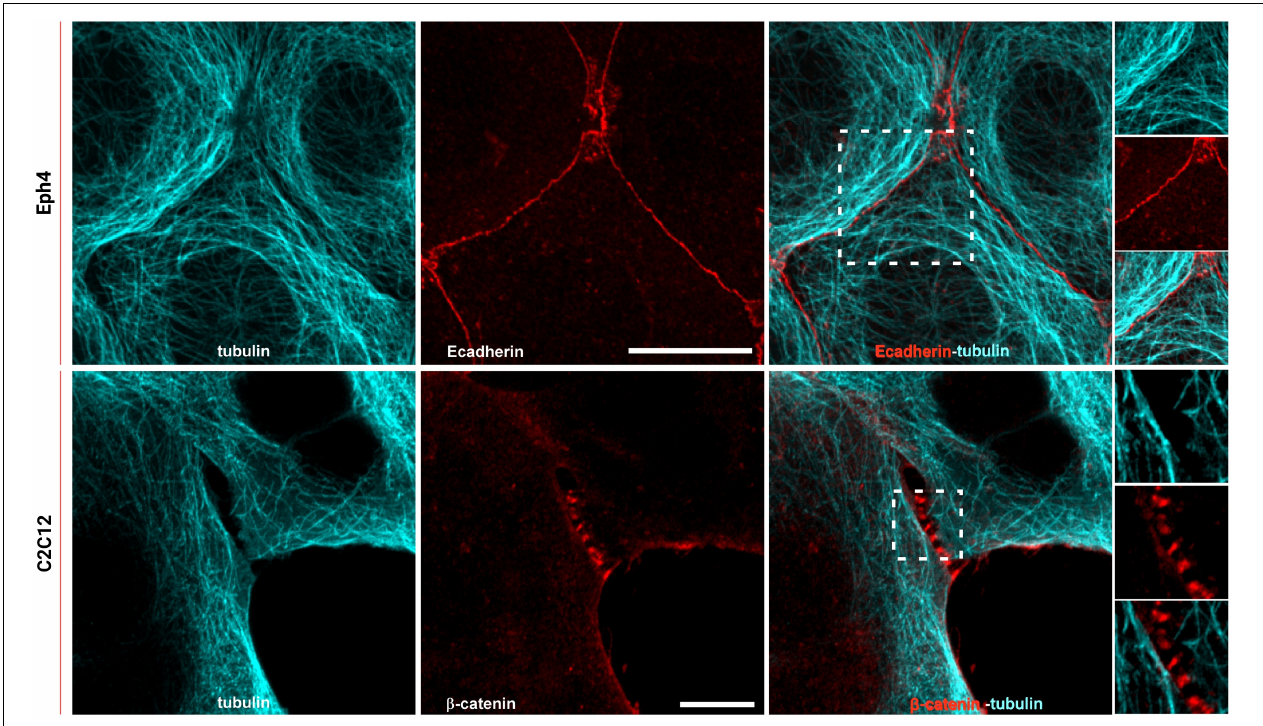
FIGURE 1 | Microtubules reach cadherin-mediated adhesions in epithelial cells but are maintained at a distance in C2C12 cells. Top: Eph4 cell monolayers labeled for tubulin (cyan) and E-cadherin (red); bottom: C2C12 cells labeled for tubulin (cyan) and β -catenin (red). Images represent microtubule staining alone, E-cadherin or β -catenin, and the merged image. In the zoom image (white box in the merge image on top panel), the overlapping of the microtubule network (cyan) with E-cadherin-mediated adhesion (red) is visible. In the zoom image (white box in the merge image on the bottom panel), it is visible that the extension of the microtubules (cyan) in C2C12 do not reach the adhesions ( β -catenin in red). Images on the top panel were acquired by spinning disk confocal microscope with a 100x objective, 1.49NA Plan-Apo (Nikon). Images on the bottom panel were acquired by LSM 880 confocal microscope with Airyscan detection with a